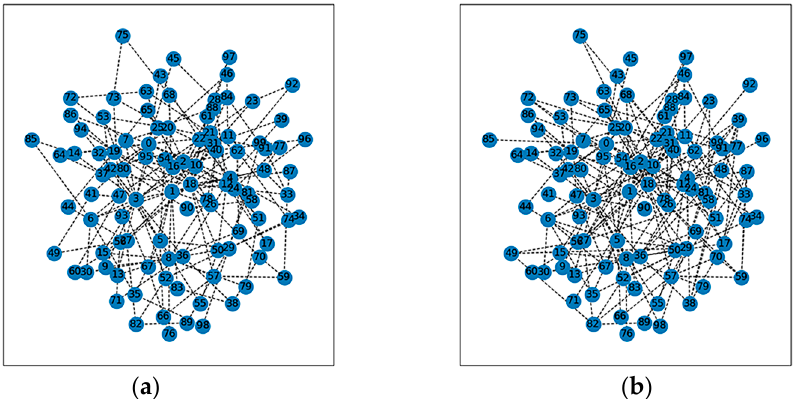
Figure 6. Network topology before and after algorithm optimization: ( a ) initial network; ( b ) opti- mized network.